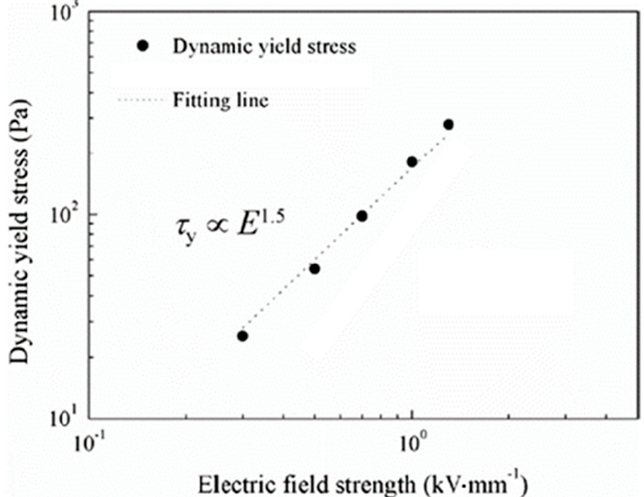
Figure 8. Dynamic yield stress vs. electric field strength for the MCC ER fluid under a series of external electric field strengths. The dotted line in the figure was obtained from the expression τ y ∝ E 1.5 (reproduced from [93]).